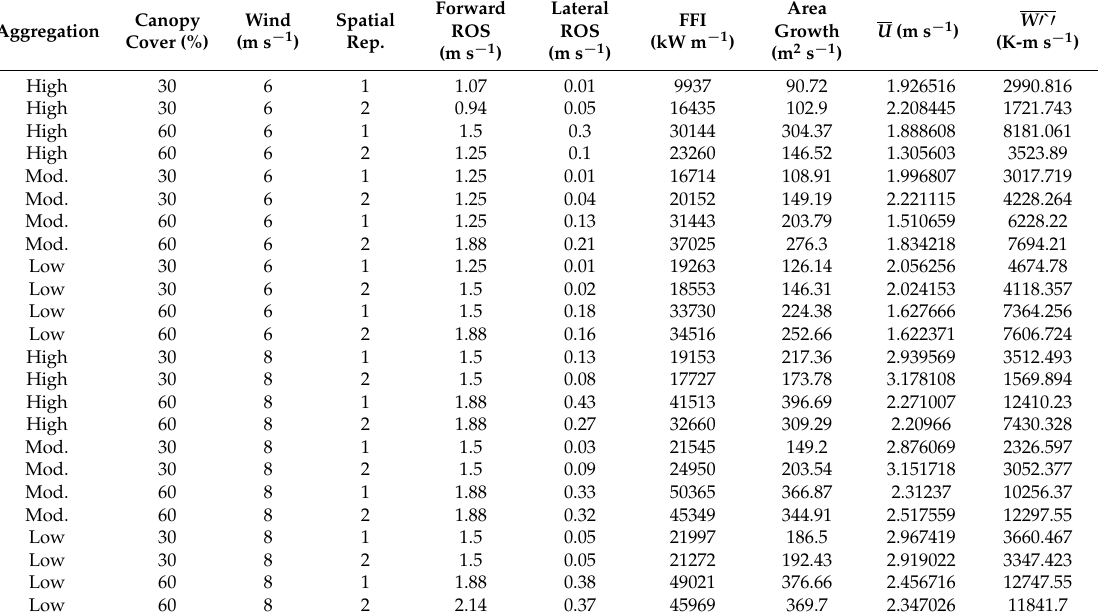
Table 1. Fire behavior metric outputs for simulations spanning two wind speeds, two levels of canopy cover, and three spatial patterns with different levels of aggregation, each with two replicates. For each simulation, results for six metrics are presented: Forward ROS (m s − 1 ), Lateral ROS (m s − 1 ), Fire front intensity (kW m − 1 ), Area growth rate, U (m s − 1 ), and W (cid:48) θ (cid:48) (K-m s − 1 ). The table has fire metrics for medium wind speed cases (top rows) and high wind speed cases (bottom rows).